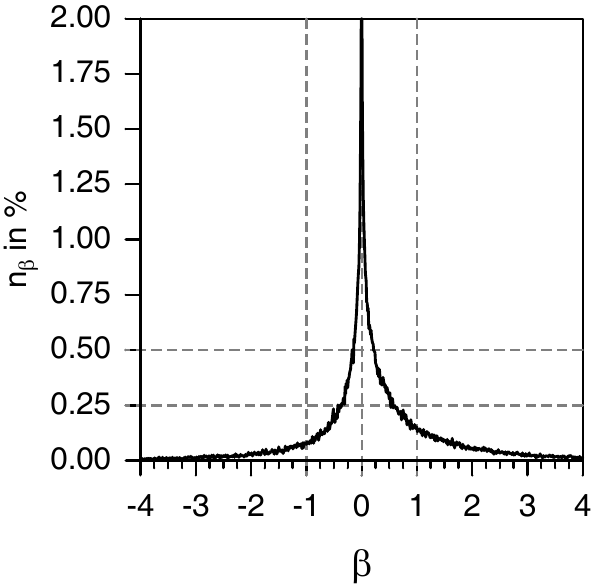
Fig. 10. Simulated relative distribution n β of β for intervals of 1β = 0.01 for 19–20 August 2005.